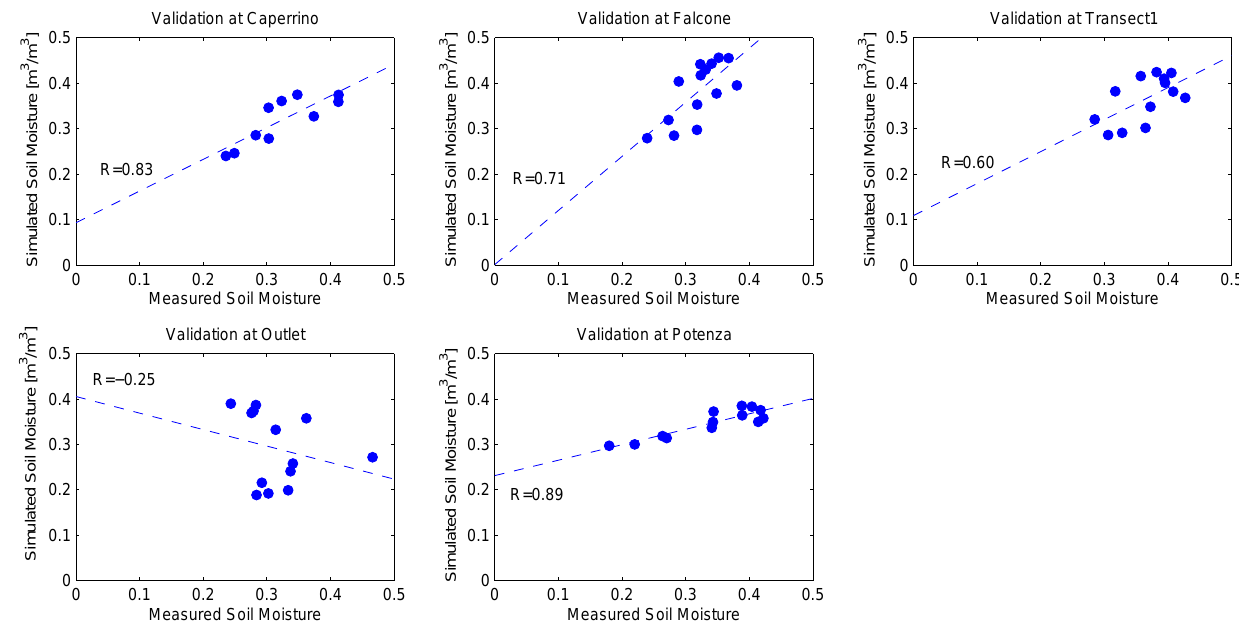
Fig. 4. Comparison between the simulated and measured SM (m 3 m − 3 ) in the five monitored sites during the field campaign.